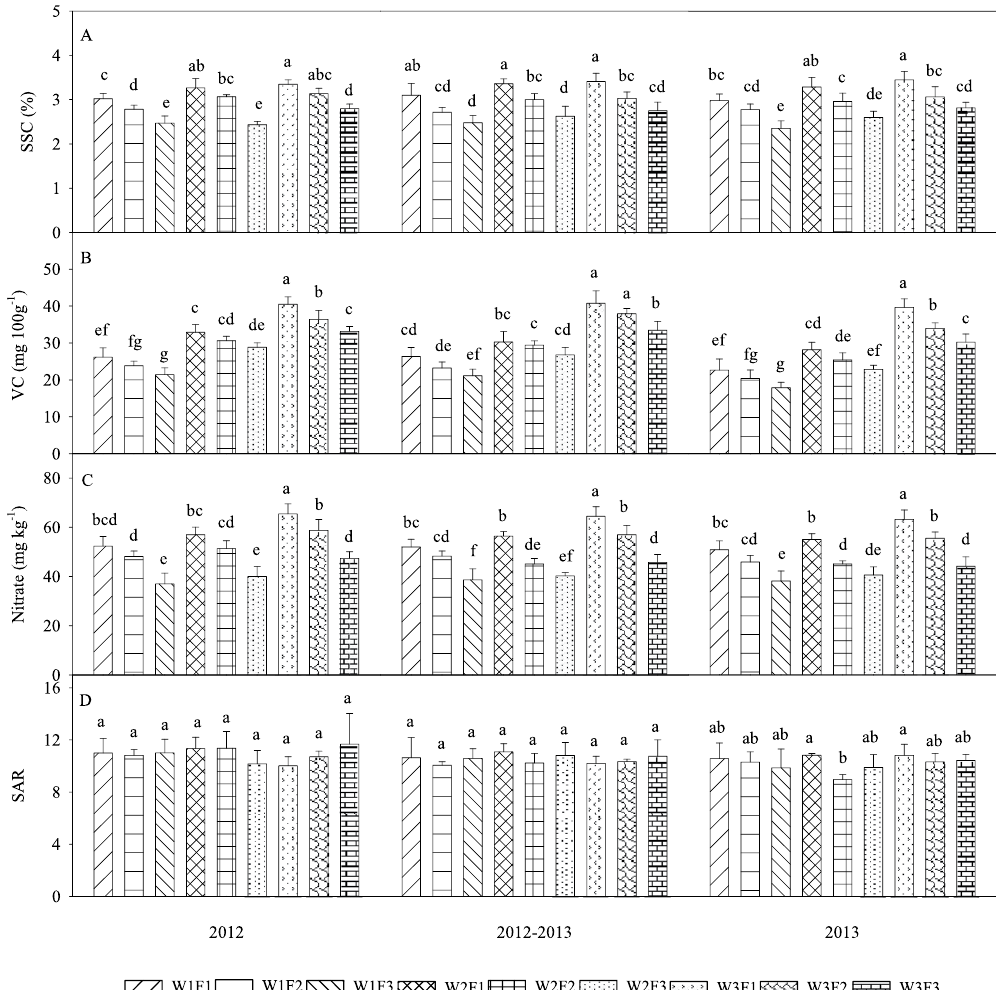
Figure 3. Effects of different irrigation and fertilization treatments on the soluble sugar content (SSC), vitamin C (VC) content, nitrate concentration (NC) and sugar/acid ratio (SAR) in fruit in three consecutive growing seasons in 2012 − 2013. Columns with the same letter represent values that are not significantly different at the 0.05 level of probability according to the LSD test. Each value is the mean ± SD (n = 3). The treatments are noted as W1, 100% ET 0 ; W2, 75% ET 0 ; W3, 50% ET 0 ; F1, N240 − P 2 O 5 120 − K 2 O150 kg ha − 1 ; F2, N180 − P 2 O 5 90 − K